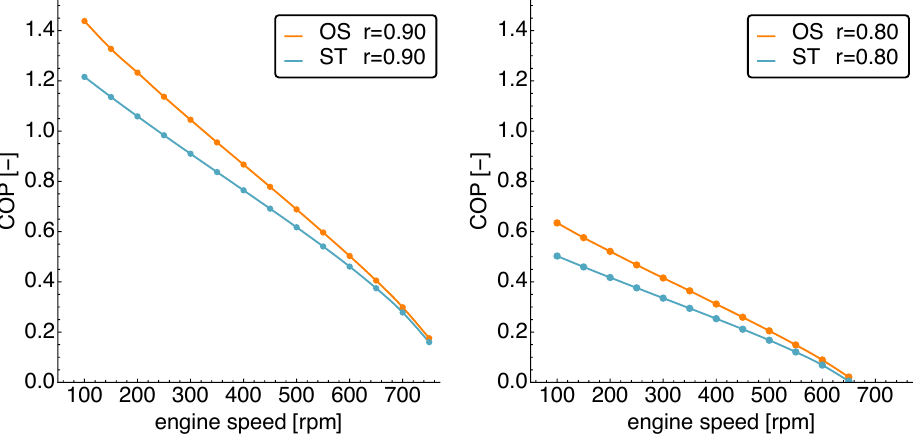
Figure 6. The base case COP vs. engine speed for OS and ST motion at different values of the regeneration coefficient ( left / right ). The larger regeneration coefficient leads to roughly doubled COP values as compared to the lower regeneration case. We note that the slower the engine operates, the larger the COP gain by optimized piston motion (OS)